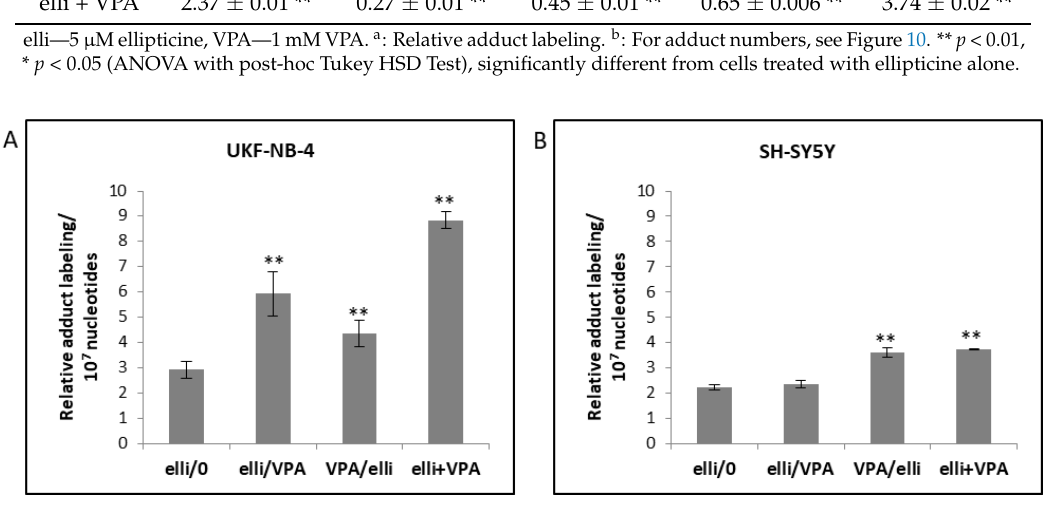
Figure 10. ** p < 0.01, * p < 0.05 (ANOVA with post-hoc Tukey HSD Test), significantly different from cells treated with ellipticine alone. 3. Discussion Our study aimed to develop strategies for how to improve the poor response of high-risk NBL to general treatment regimens. One of the promising regimens effective against some tumor cells including NBL use DNA-damaging cytostatics such as doxorubicin, etoposide, or cisplatin in combination with several HDAC inhibitors (for a review see [15,20,22–28,56]). Therefore, we continued to investigate the effects of the HDAC inhibitor VPA combined with the DNA-damaging drug ellipticine in NBL cells. We employed two types of NBL cells differing in the amplification of the N-myc gene, namely UKF-NB-4 cells with and SH-SY5Y cells without N-myc amplification), because the status of this gene affects NBL biology [46]. Previously, it was found that over-expression of N-myc sensitizes neuroblastomas to death-receptor-induced apoptosis [57,58]. Of all genetic aberrations identified, N-myc amplification was the most important prognostic factor that